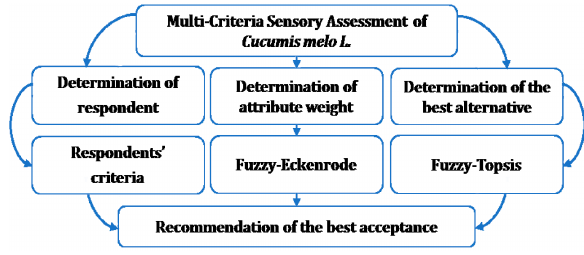
Figure 3 Research framework